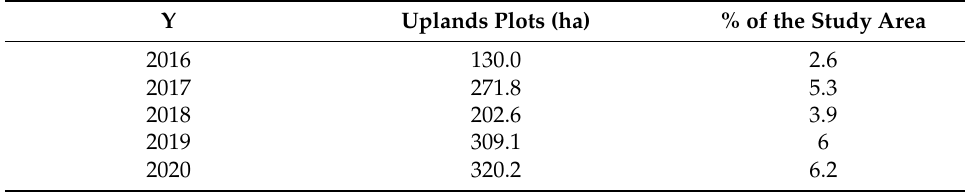
Table 4. Houaylack-Vangven shifting cultivation extension, 2016–2020.